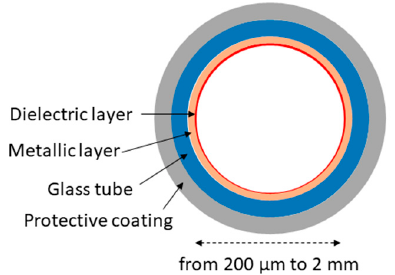
Figure 3. Schematic diagram of the construction of a typical glass hollow waveguide. Metallic and dielectric layers are usually made of silver (Ag) and silver iodine (AgI), respectively.